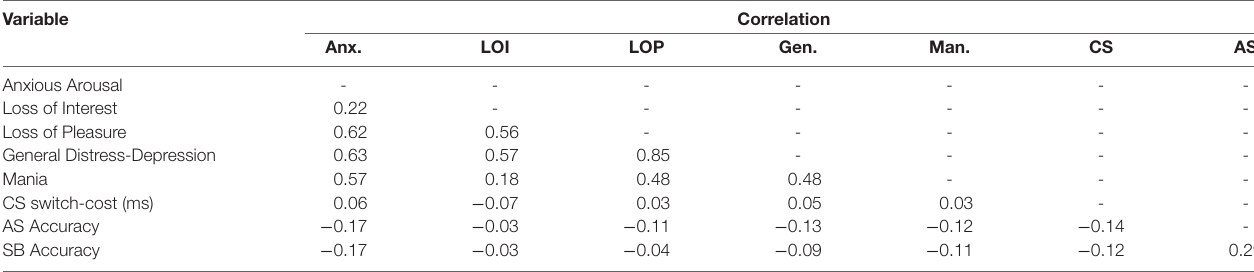
TABLE 4 | Correlations between symptom measures (total scores) and task measures. Variable